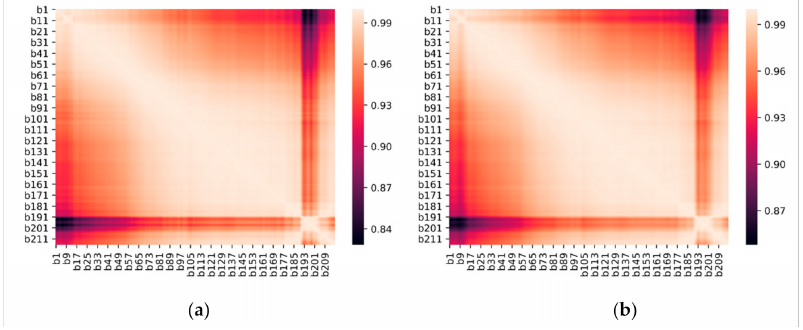
Figure 10. Visible-near-infrared band correlation thermal map: ( a ) original spectra; ( b ) power- logarithmic transformation